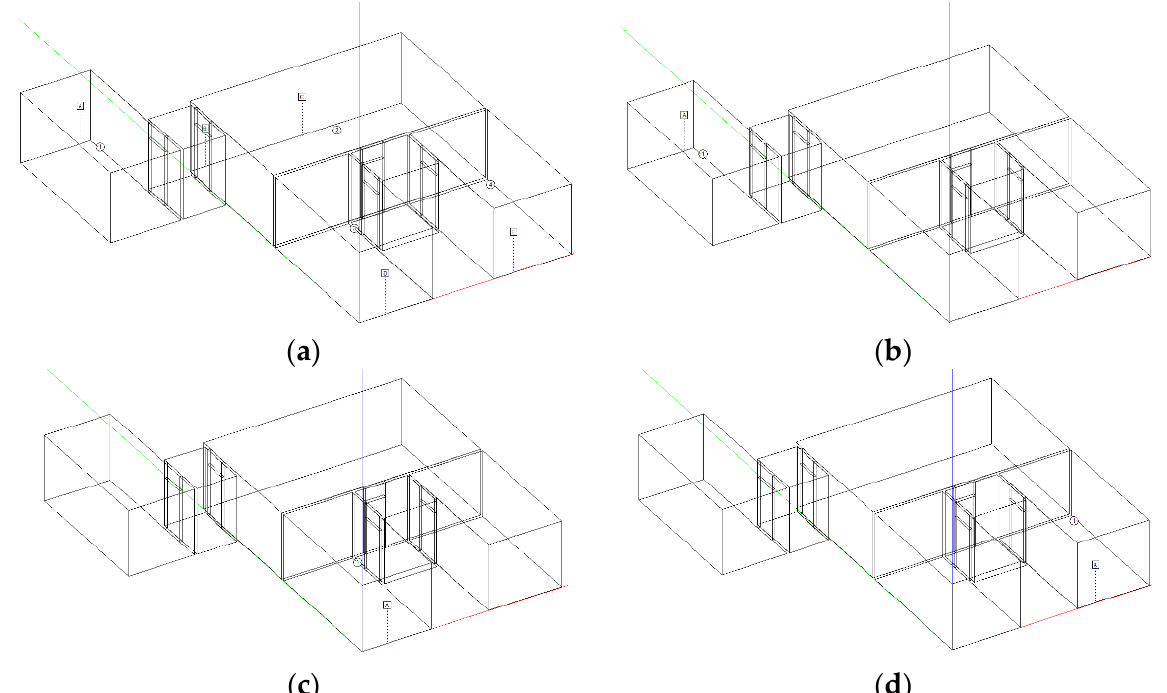
Figure 18. Four-room apartment. Night configuration: ( a ) all CVM on, ( b ) only bedroom 1 CVM on, ( c ) only bedroom 2 CVM on, ( d ) only bedroom 3 CVM on.